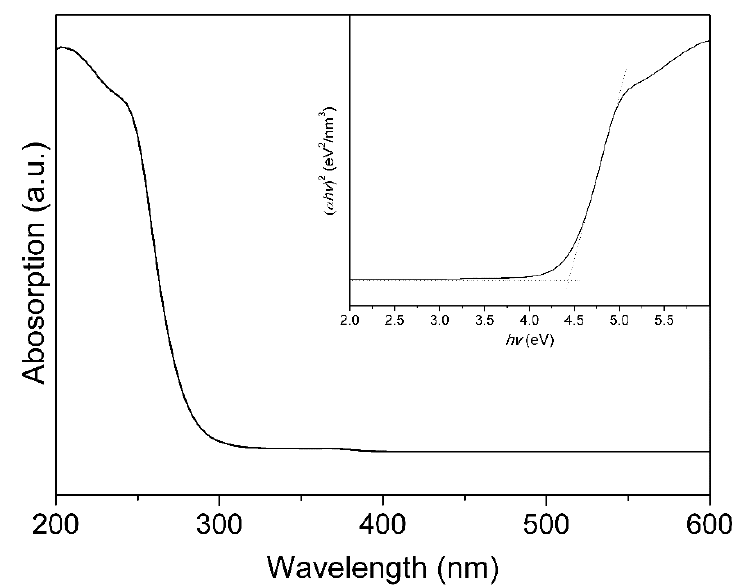
Figure 3. Ultraviolet–visible diffused reflectance spectrum (UV–Vis DRS, or DRS) for ZnGa 2 O 4 .